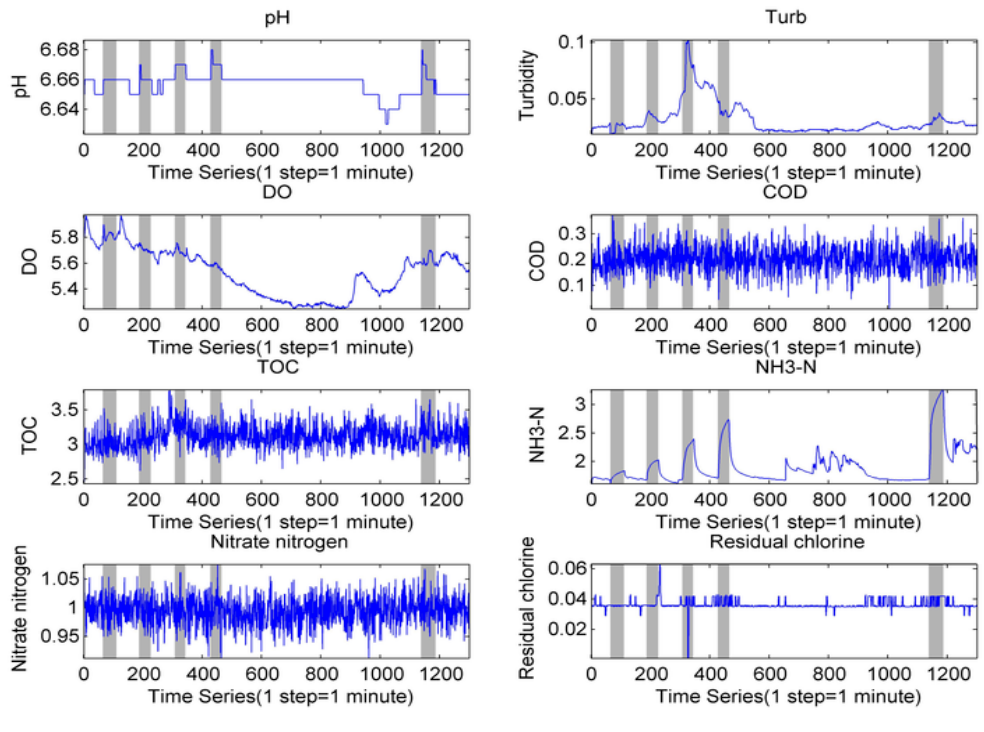
Figure A1. Sensors’ responses for ammonium citrate.